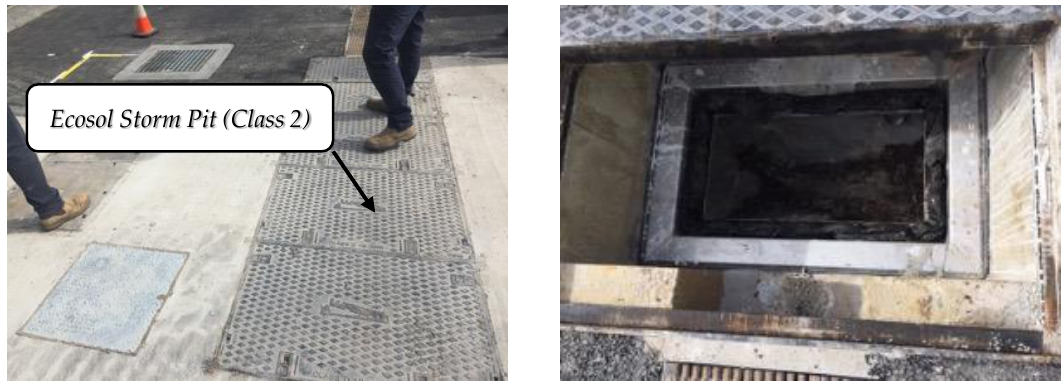
Figure 2. Installed Ecosol Storm Pit (Class 2).